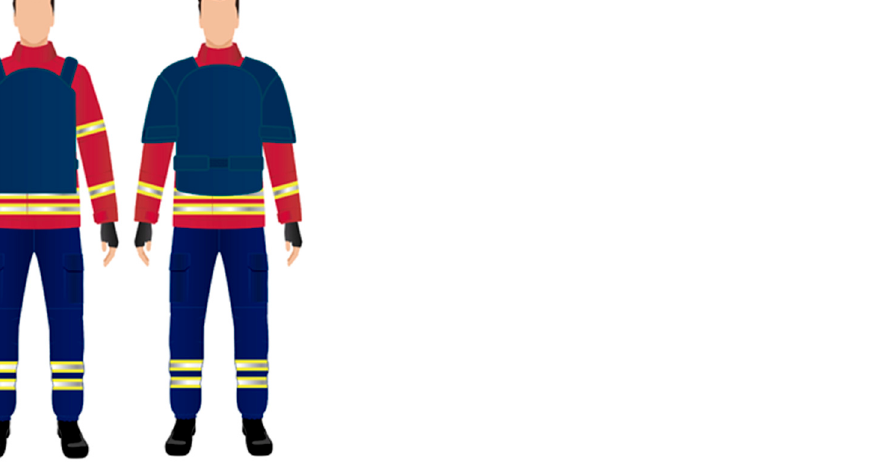
Figure 4. Study of a PCM vest design: ergonomic ( left ) and enhanced protection ( right ).